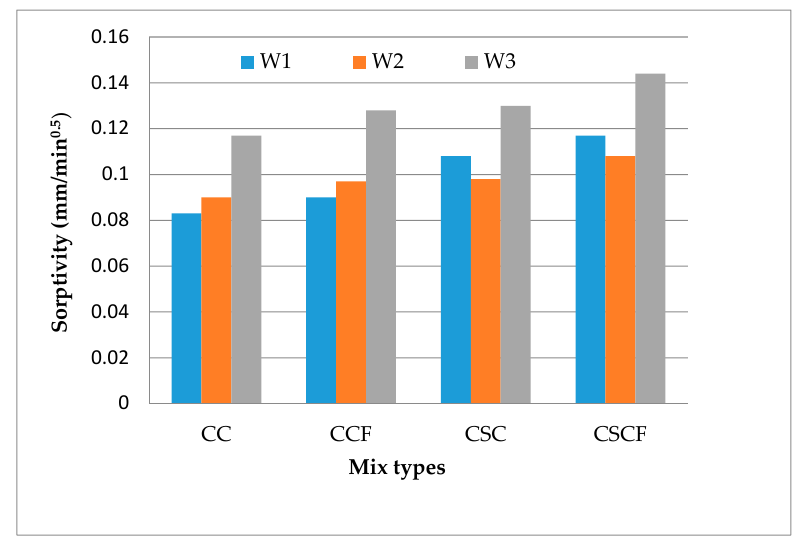
Figure 8. Results of sorptivity test.